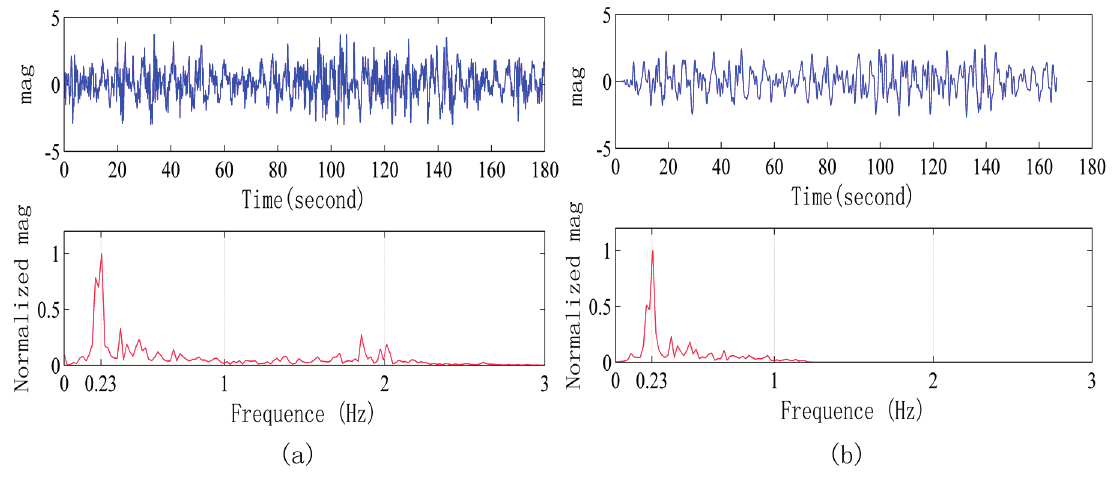
Figure 9. Signals collected in a strong interference environment when the radar is 3 m away from the human body. ( a ) Original signal waveform and frequency spectrum; ( b ) Signal after FIR filter processing and its frequency